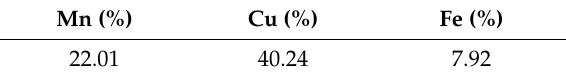
Table 1. Chemical composition of black oxide